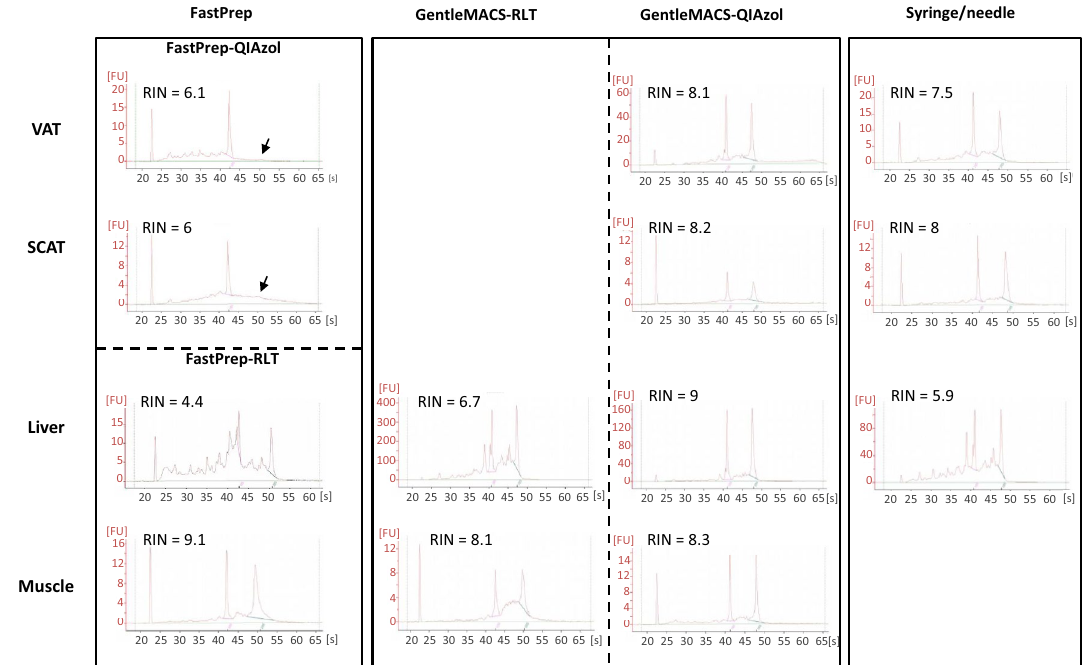
Figure 4. Electropherograms obtained with different homogenization buffers and methods. Electropherograms were obtained using 2100 Bioanalyser and RNA 6000 Nano chips. Typical electrophoretic traces and RIN are shown for VAT, SCAT, liver, and muscle. VAT visceral adipose tissue, SCAT sub-cutaneous adipose tissue. FastPrep for FastPrep-24 Instrument, GentleMACS for GentleMACS Dissociator.